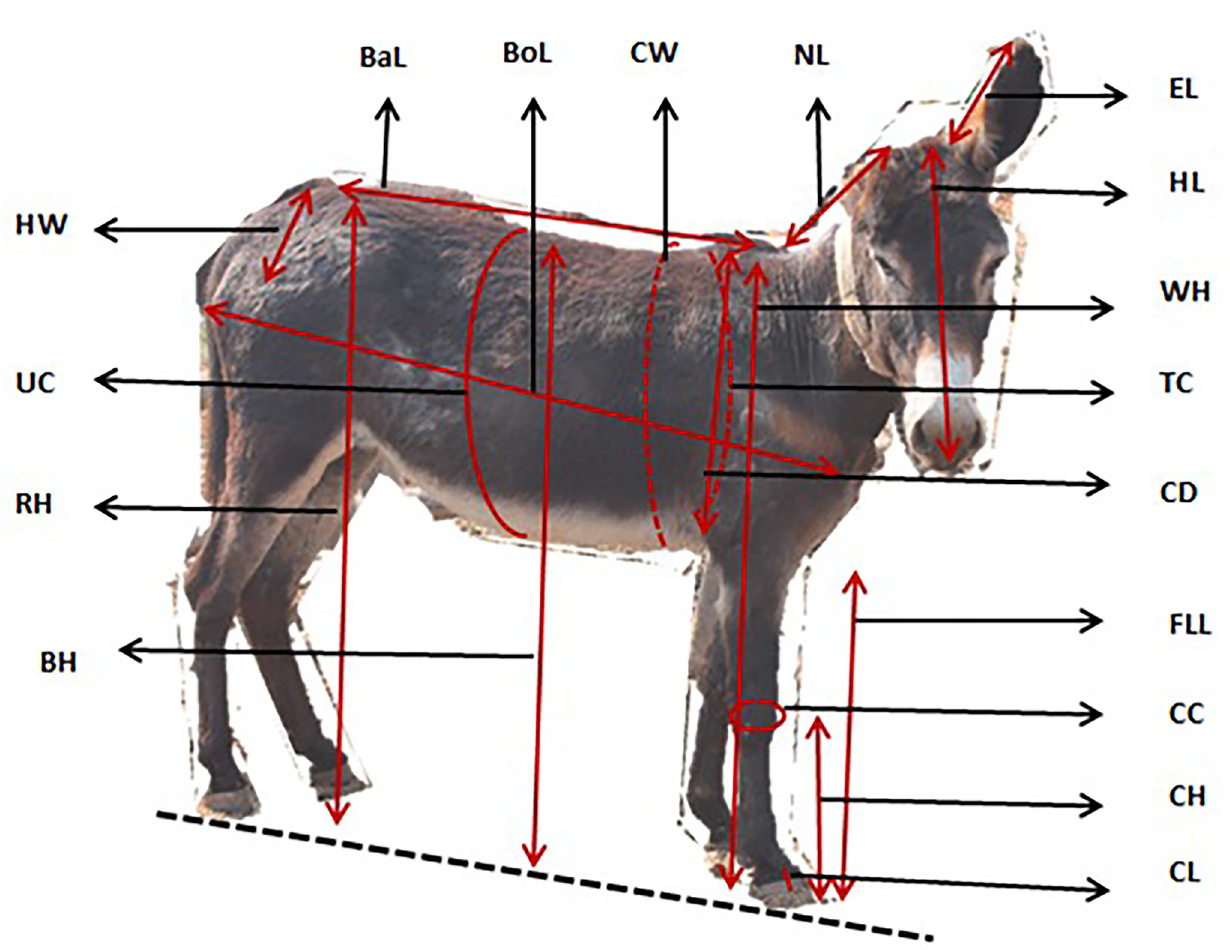
Fig 1. Different body measurements performed in